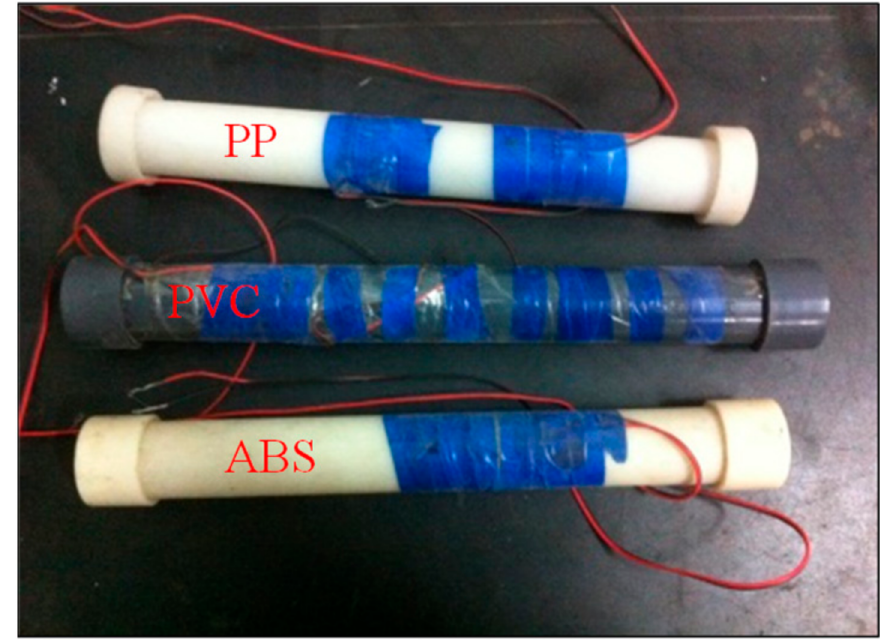
Figure 2. ABS, PP, and PVC screen pipe samples.